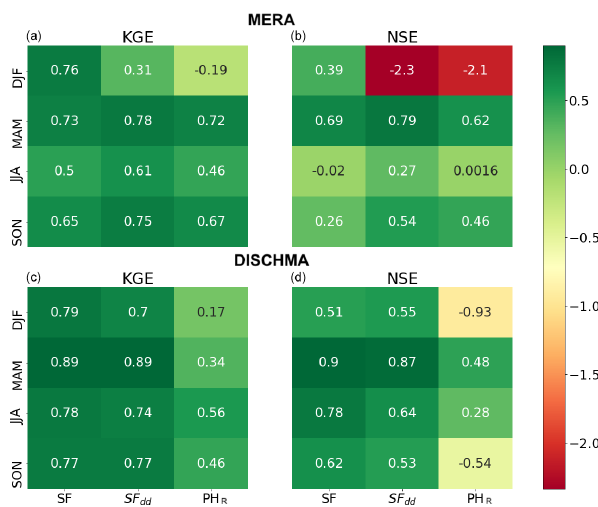
Figure 8. Seasonal KGE (a, c) and NSE (b, d) scores obtained over the Mera (top panels) and Dischma (bottom panels) catchments. Scores are shown for the two versions of A3D + SF and for PH R